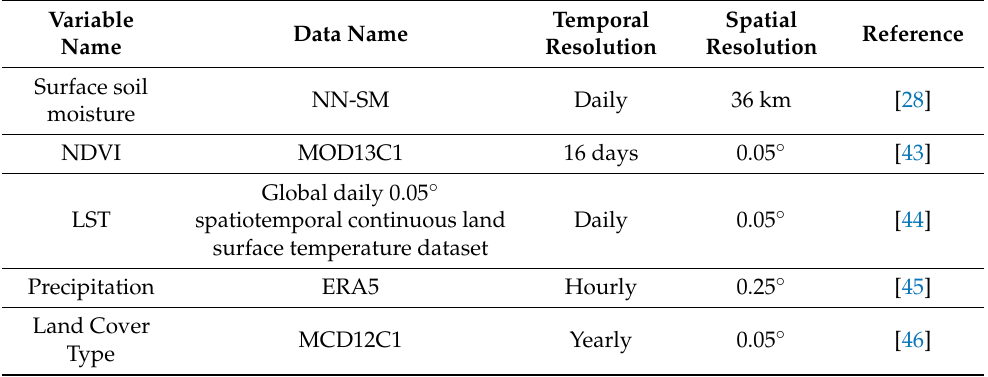
Table 1. The remote sensing data used in this